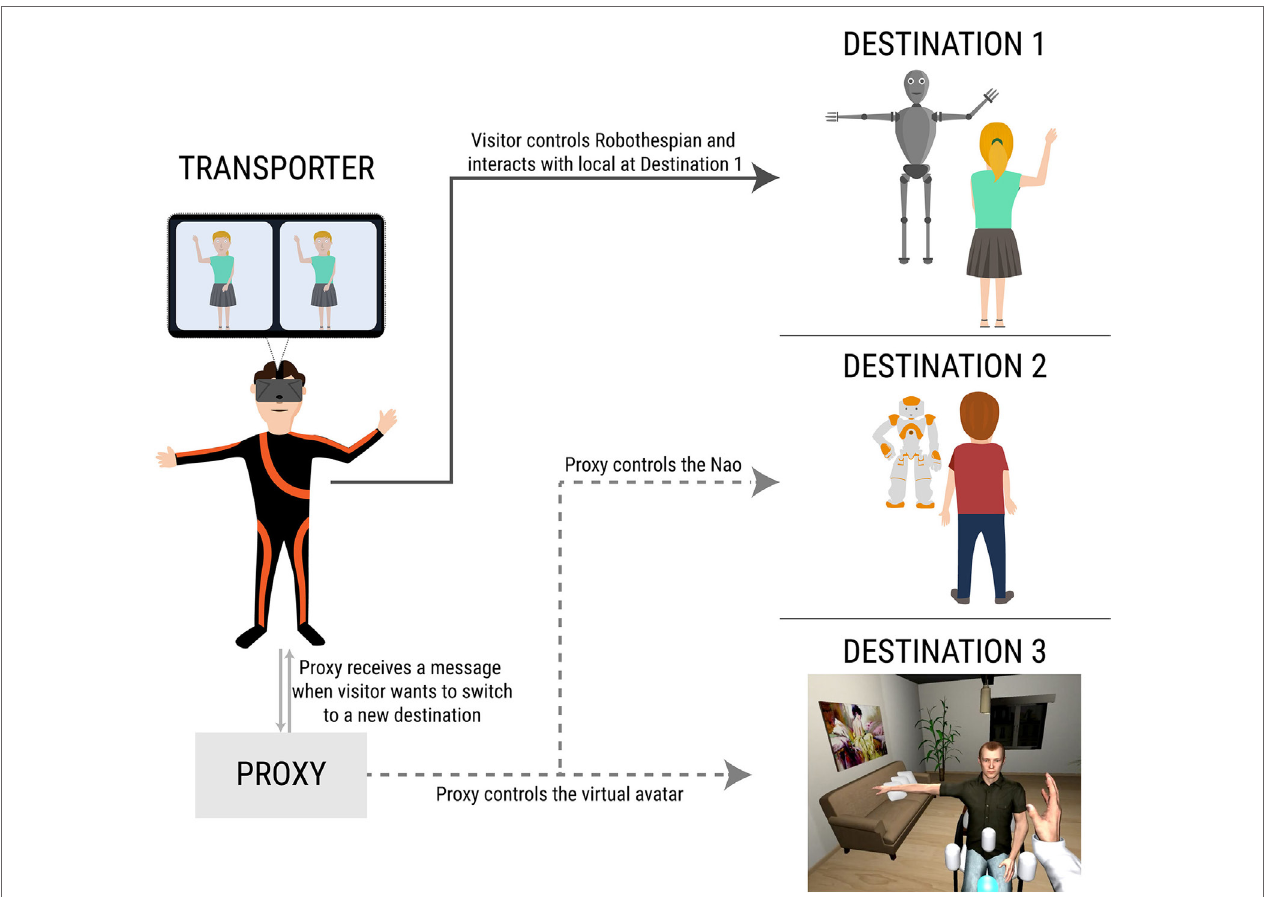
FigUre 3 | an illustration that describes the experiment setup . The visitor can be in one destination at any given point and is in full control of the robot (or avatar) present there. Concurrently, the proxy system is in control of the other two visitor representations in the other destinations. A message is sent to the proxy when the visitor wants to switch to another destination, which tells the proxy to take over the destination previously occupied by the visitor, after handing over control to the visitor at the new